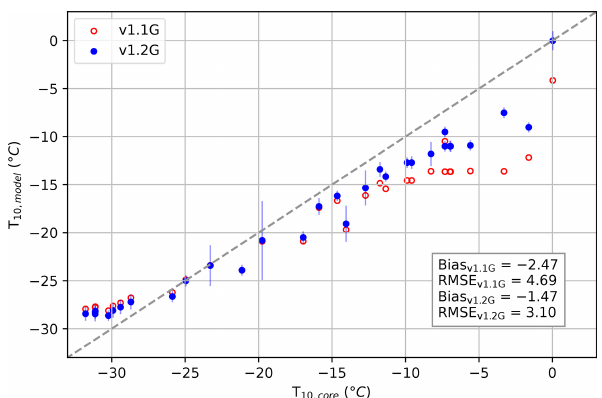
Figure 7. Modelled vs. observed temperature at 10m depth (in ◦ C) for 31 locations on the